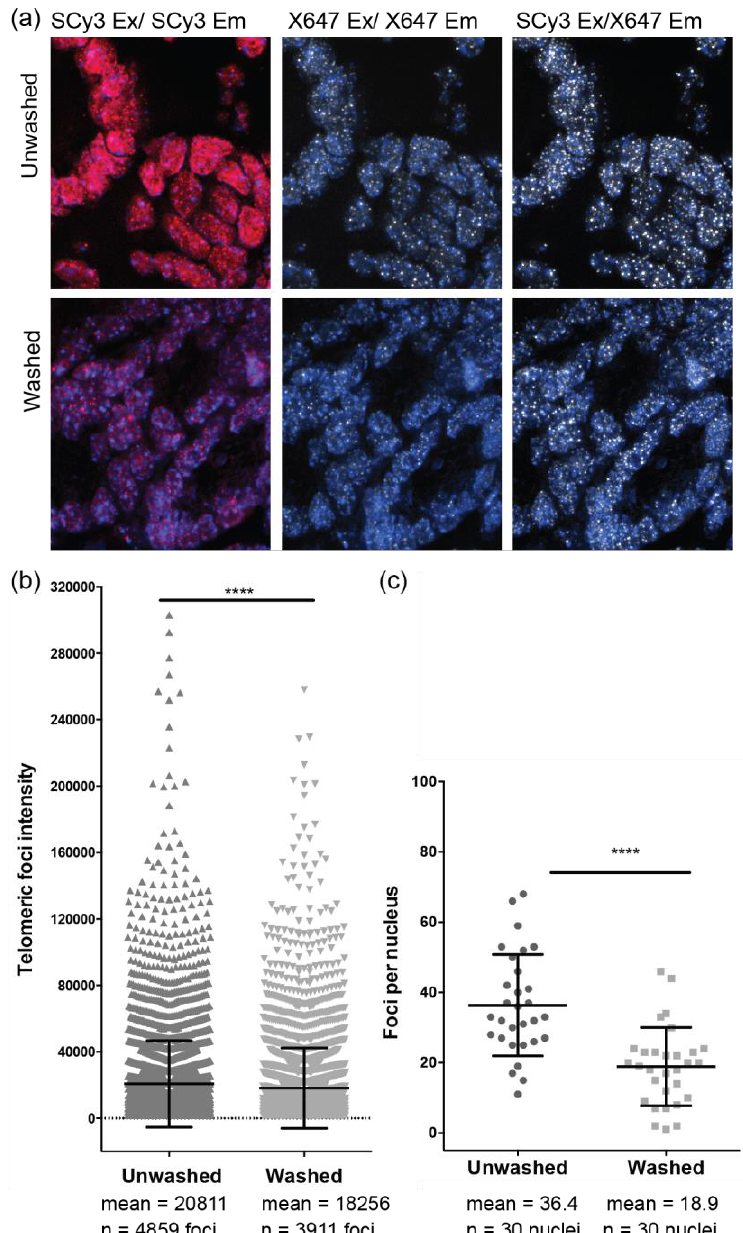
Figure 7. Imaging of mouse intestinal tissue using FRET pair miniprobes. ( a ) Formalin fixed and paraffin embedded section of mouse colon were stained with a mixture of the SCy3-γPNA and X647-γPNA probes (1:1 ratio) by FISH with and without wash steps following hybridization. Images were captured using filters for SCy3 excitation and emission (red), X647 excitation and emission (white) or SCy3 excitation and X647 emission (white, FRET channel). Fluorescence signal intensities for ( b ) each telomeric foci and ( c ) the number of telomeric foci per nucleus were measured in the FRET channel for unwashed and washed samples. Mean and SEM from total foci are shown. **** p < 0.0001, unpaired t -test.